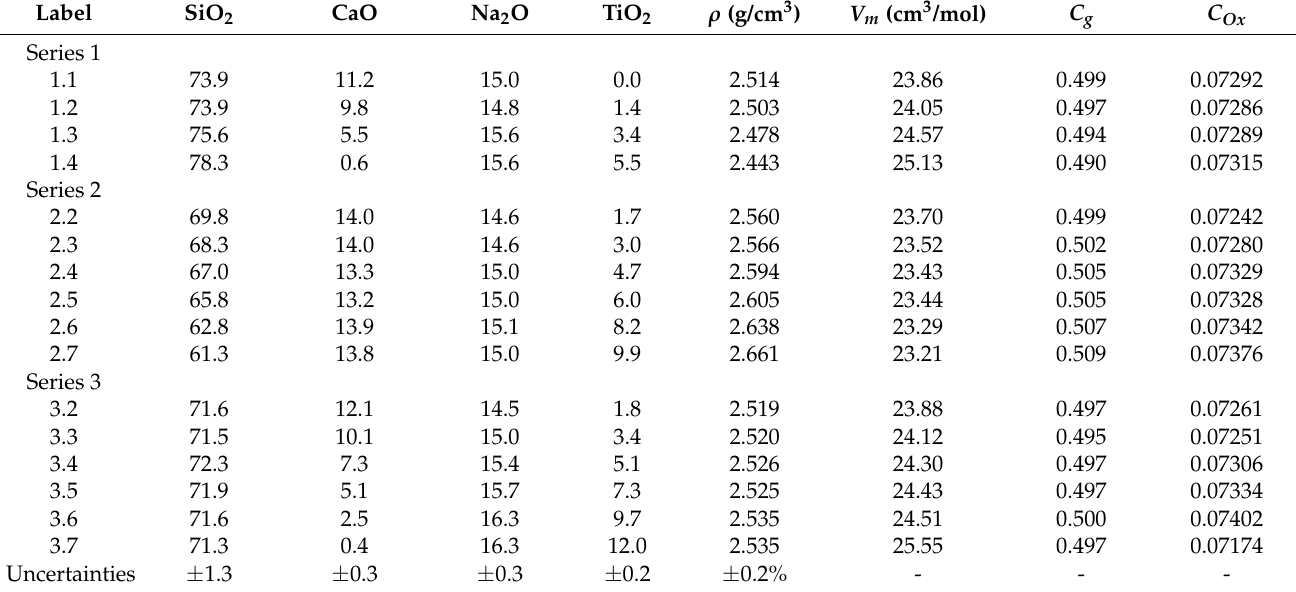
Table 1. Normalized glass compositions in mol% as analyzed by LA-ICP-MS, density ( ρ ), molar volume ( V m ), atomic packing density ( C g ) and oxygen packing density ( C ox ). The data were taken from refs [24,39] apart from C ox